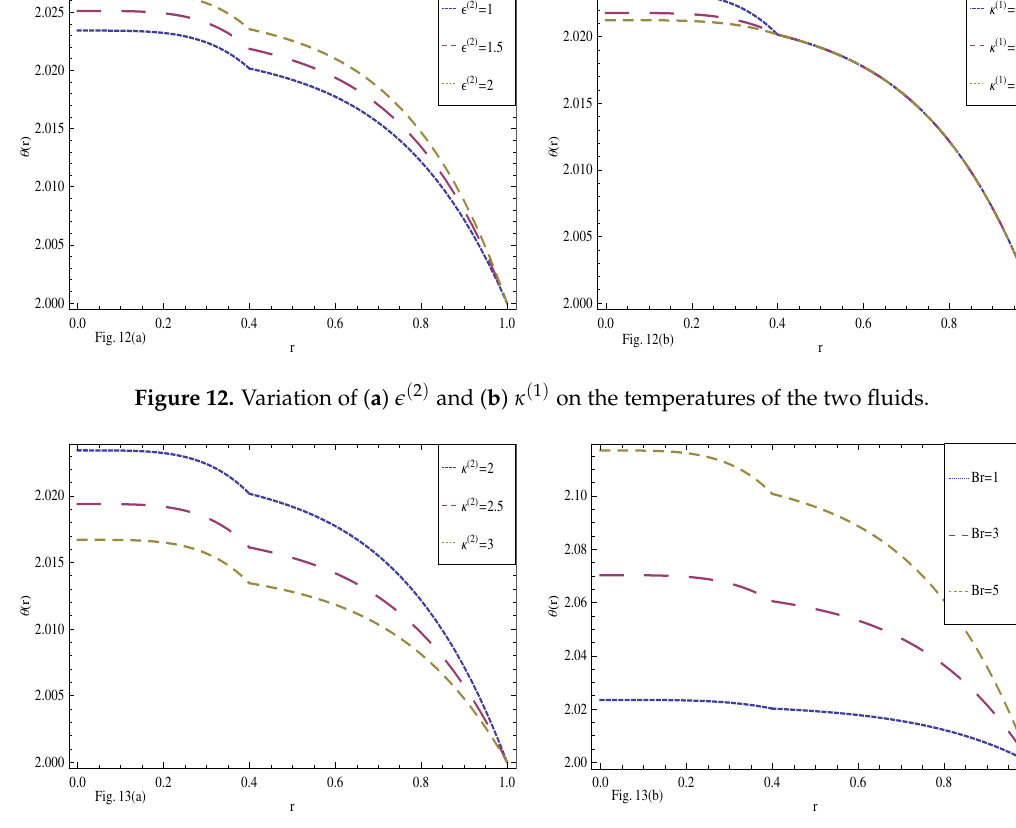
Figure 13. Variation of ( a ) κ ( 2 ) and ( b ) Br on the temperatures of the two